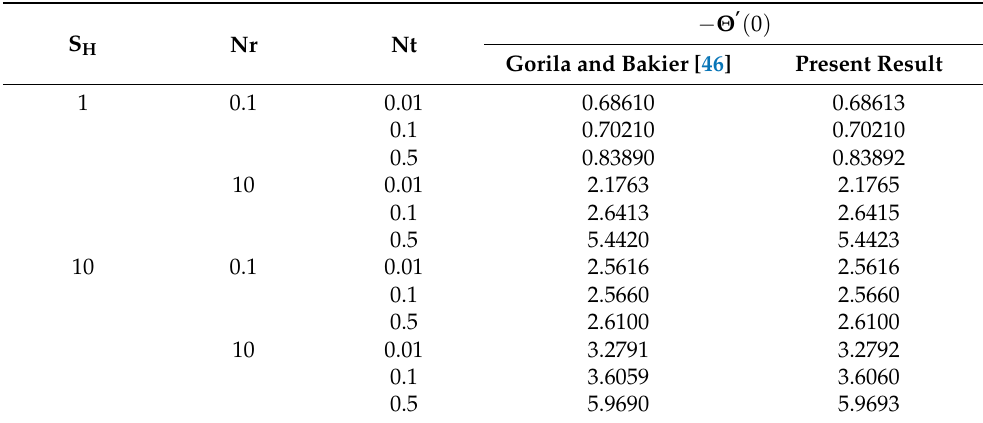
Table 3. Validation of present work with existing literature by taking parameters values as C = Nc